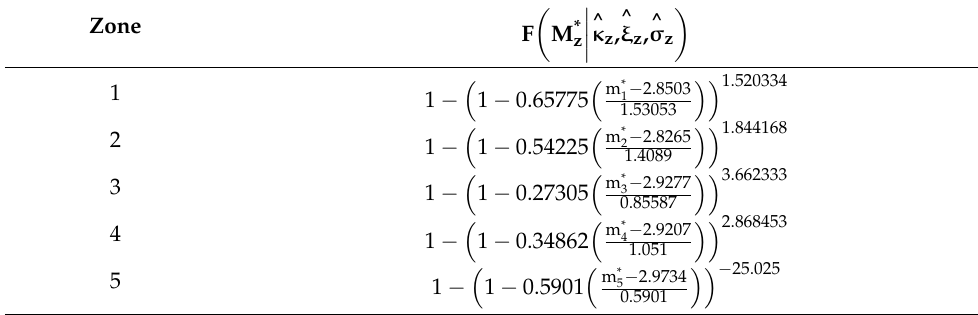
Table 11. The result of the parameter estimation and the KS test in Cluster Type II. Parameter Value Zone